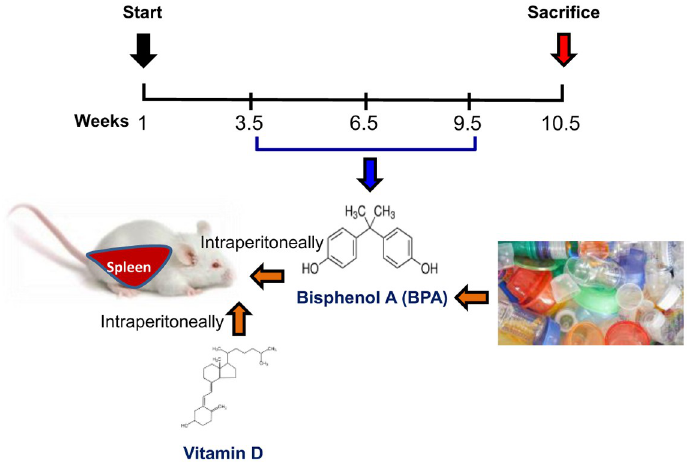
Fig 1. Schematic of the treatment